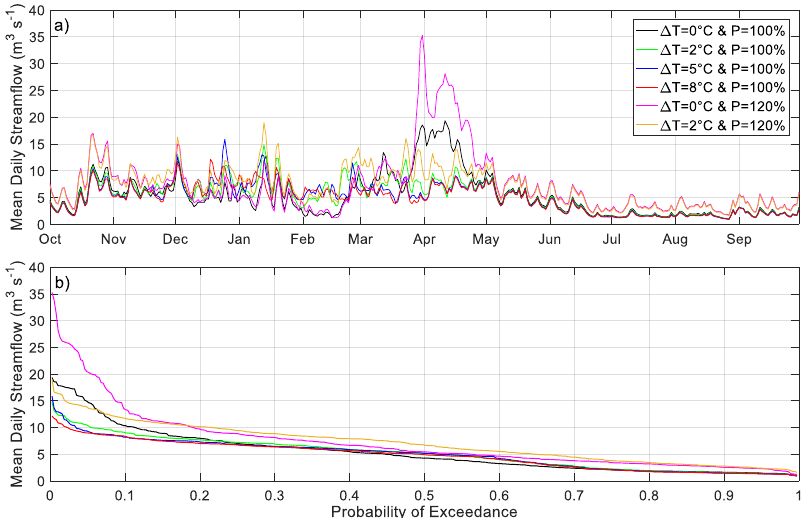
Figure 11. Changes in mean daily streamflow in response to selected warming and increasing precipitation scenarios. Changes in ( a ) mean daily streamflow, and ( b ) exceedance probability of mean daily